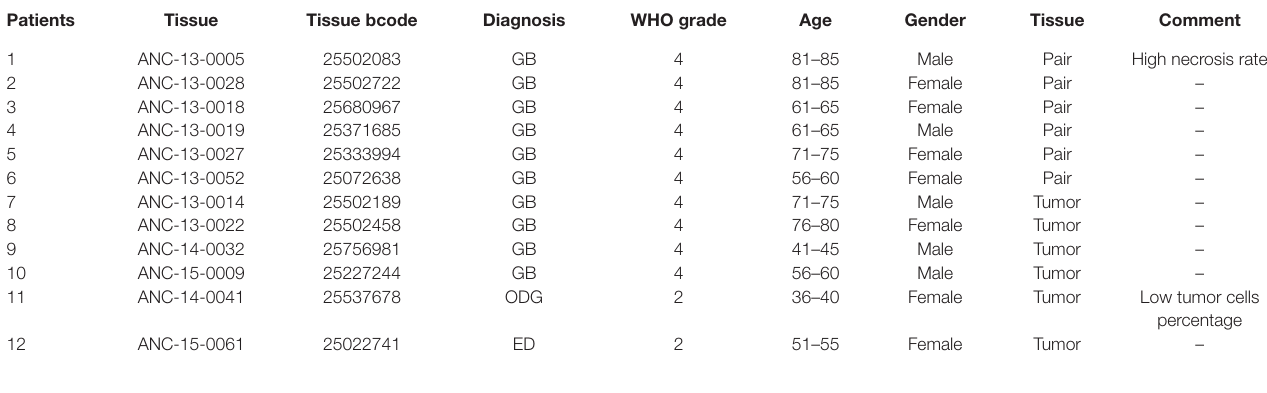
TABLE 2 | Clinical characteristics of patients with brain tumor in this study. GB, glioblastoma; ODG, oligodendroglioma; ED, ependymoma. Patients Tissue Tissue bcode Diagnosis WHO grade Age Gender